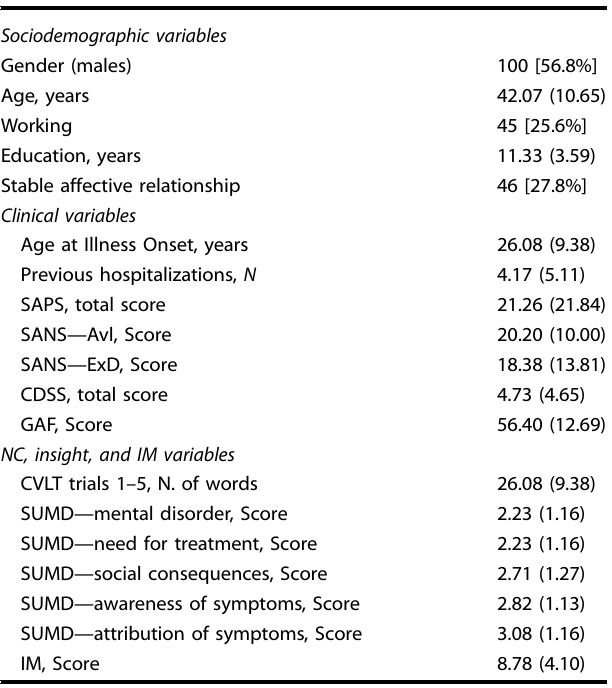
Table 1. Characteristics of the sample ( n = 176).